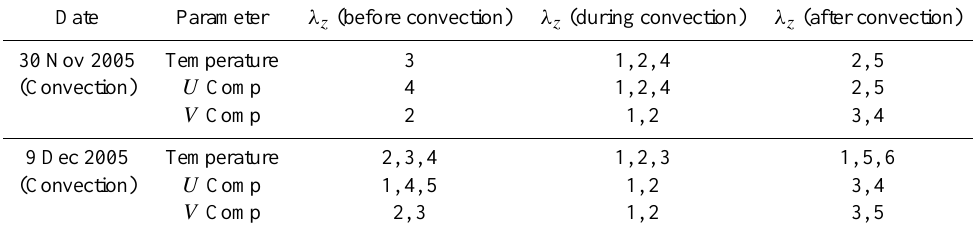
Table 3. Dominant vertical wavelengths in temperature, U and V wind components are shown.